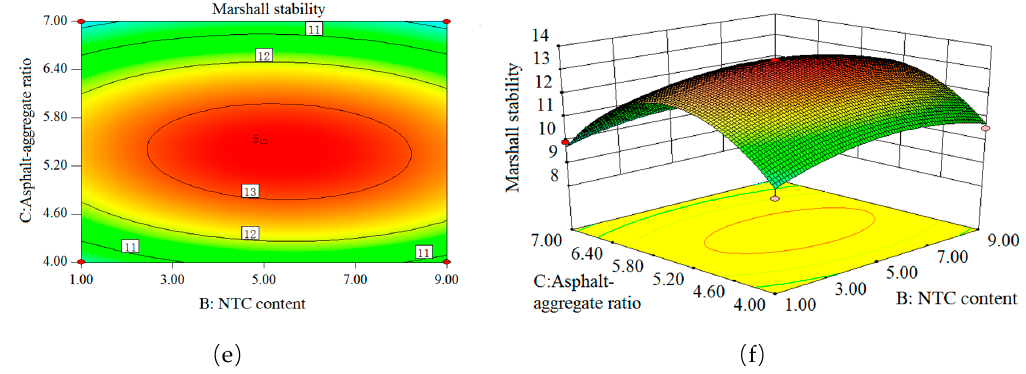
Figure 8. Contour maps and response surface maps of the Marshall stability and influencing factors. ( a ) Contour map between basalt fiber content, NTC content and Marshall stability; ( b ) Three-dimensional surface graph between basalt fiber content, NTC content and Marshall stability: ( c ) Contour map between basalt fiber content, asphalt – aggregate ratio and Marshall stability; ( d ) Three-dimensional surface graph between basalt fiber content, asphalt – aggregate ratio and Marshall stability; ( e ) Contour map between asphalt – aggregate ratio, NTC content and Marshall stability; ( f ) Three-dimensional surface graph between asphalt – aggregate ratio, NTC content and Marshall stability.